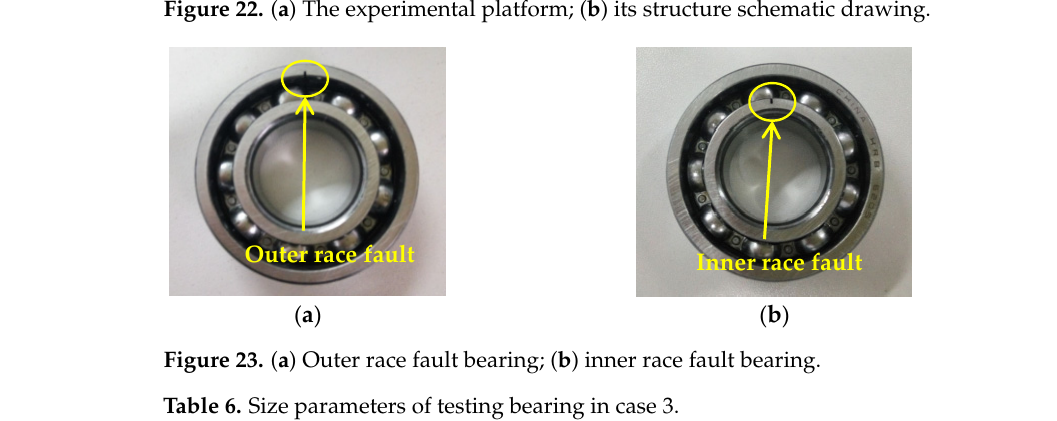
Figure 22. ( a ) The experimental platform; ( b ) its structure schematic drawing.